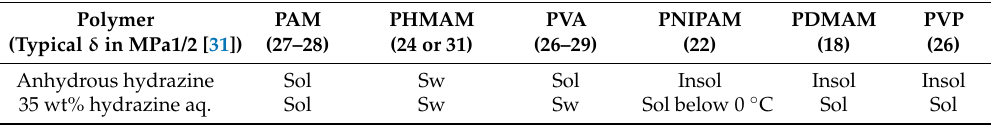
Table 1. Solubility of water-soluble polymers in hydrazine and 35 wt% hydrazine aq. Table 1 . Solubility of water-soluble polymers in hydrazine and 35 wt% hydrazine aq.